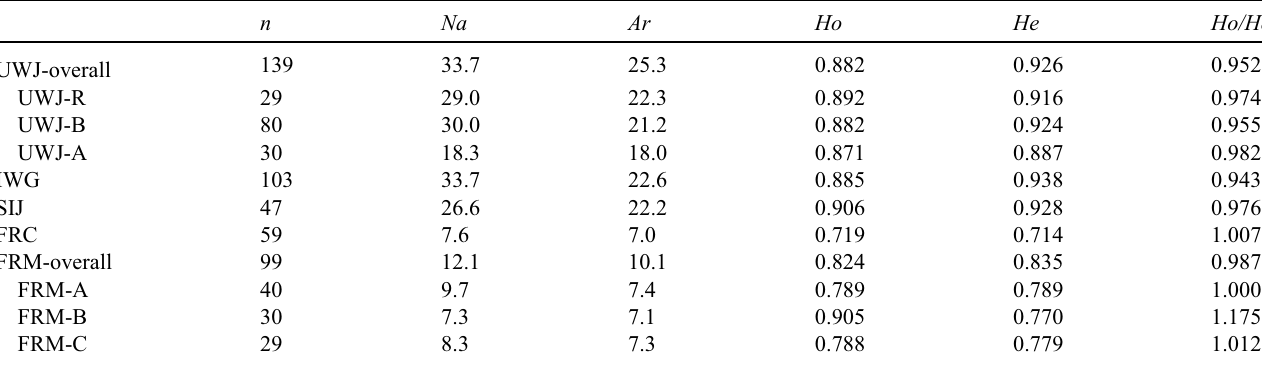
Table 2. Population genetic parameters of populations used in this study. n Na Ar Ho He Ho/He